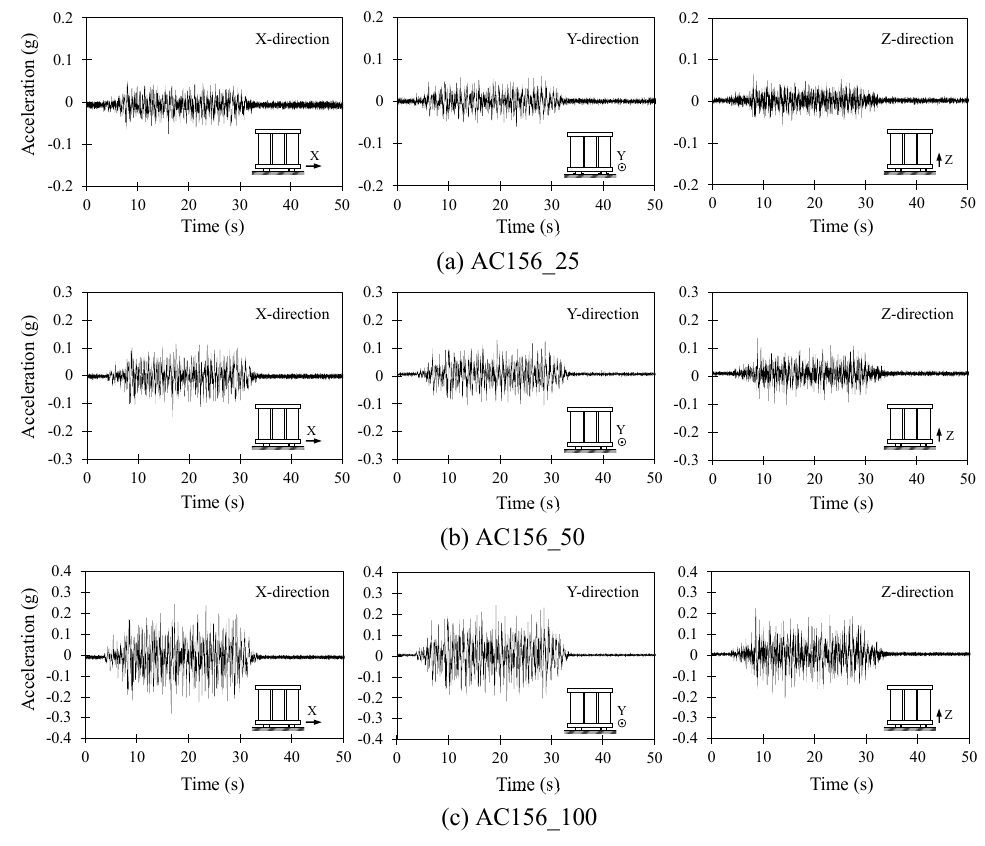
Figure 4. Input ground motion time histories used in dynamic analyses. Table 4. Peak ground acceleration used in shaking table tests.